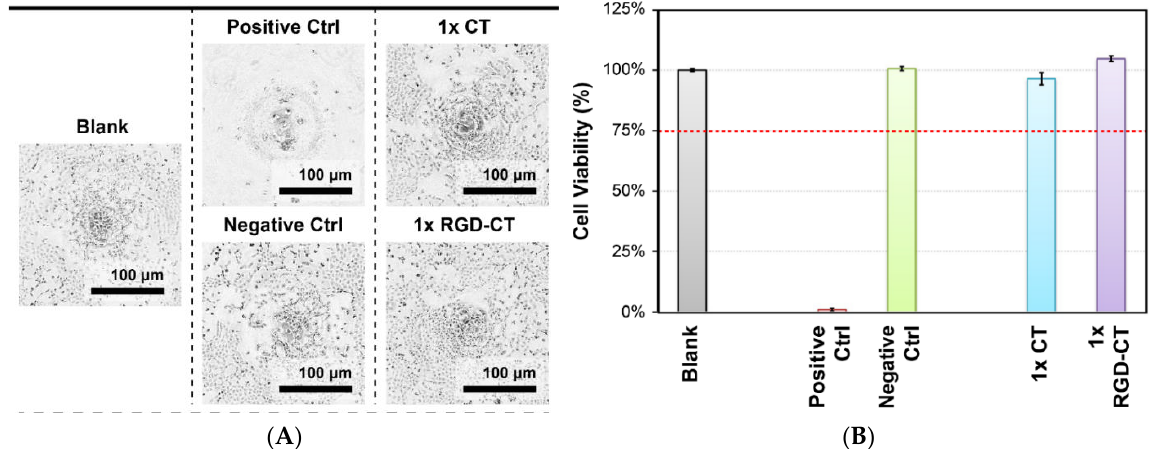
Figure 5. Cell viability tests. ( A ) EC-6 cells morphology of Blank, Positive control, Negative control, Chitosan (1 × CT), and RGD−Chitosan conjugate (1 × RGD−CT). ( B ) WST-1 test of EC-6 cells in of Blank, Positive control, Negative control, Chitosan (1 × CT), and RGD−Chitosan conjugate (1 × RGD−CT) for three days. 1 × CT and 1 × RGD−CT is 3 mg/mL.